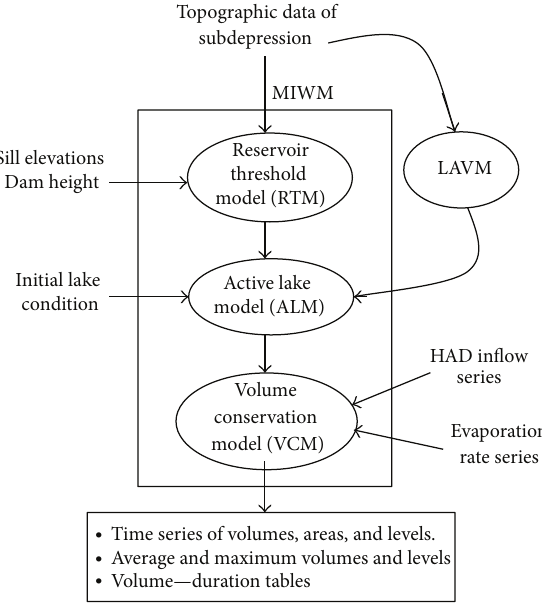
Figure 3: Interactive structure of the simulation